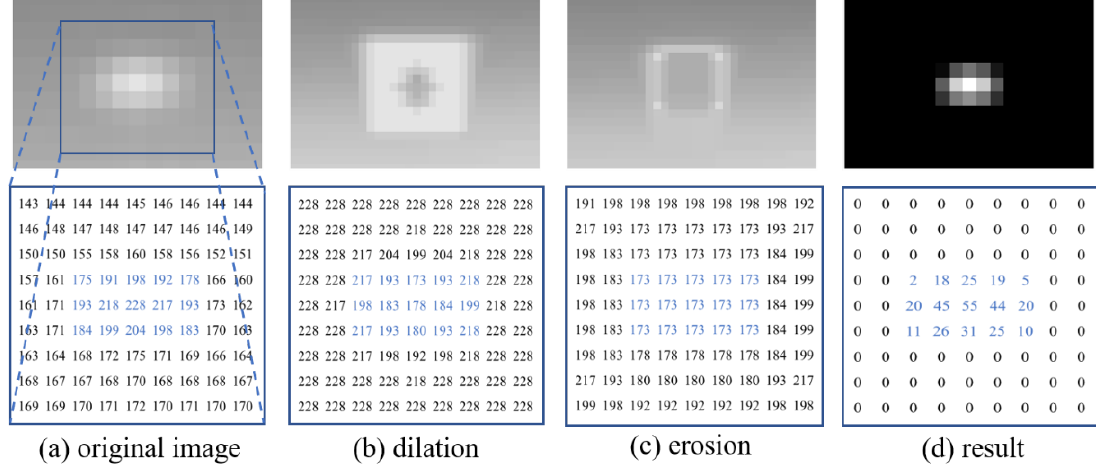
Figure 6. The process of morphological filtering: ( a ) Small target area in the original image; ( b ) dilation; ( c ) erosion; ( d ) the results of our improved NWTH. A 9 × 9 matrix of the target region is shown at each step.